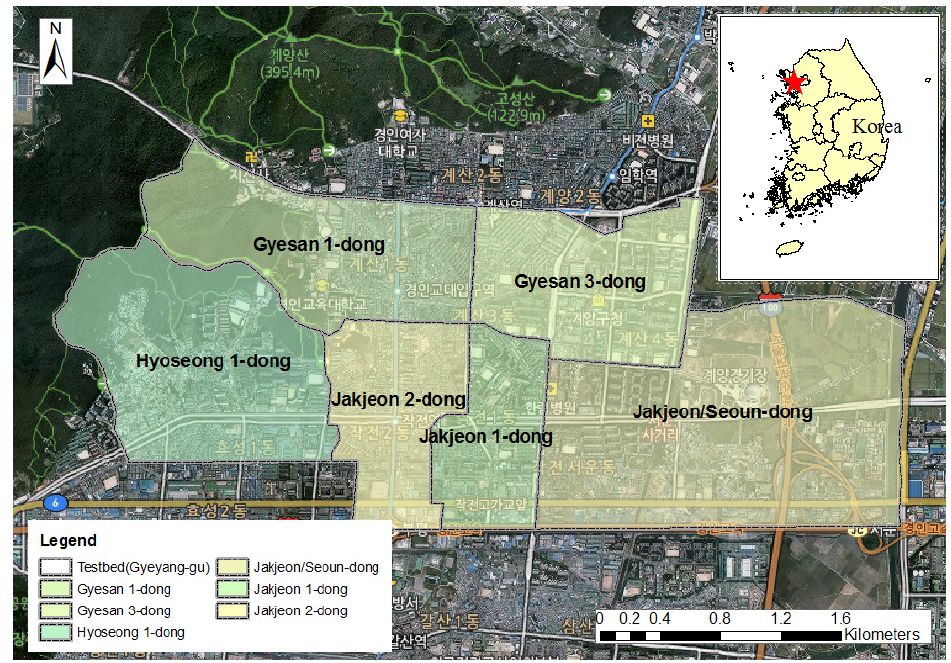
Figure 5. The study area (Gyeyang-gu); gray line denotes the administrative district of Gyeyang-gu (Incheon, Korea).